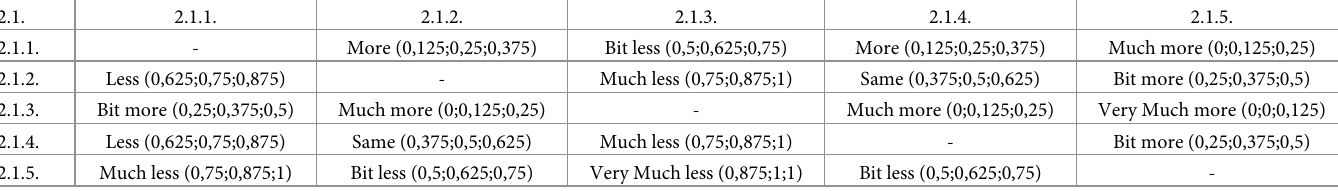
Table 3. RD expert’s response to the questionnaire regarding impact on Scope: Sub-group ‘Plant Location’.